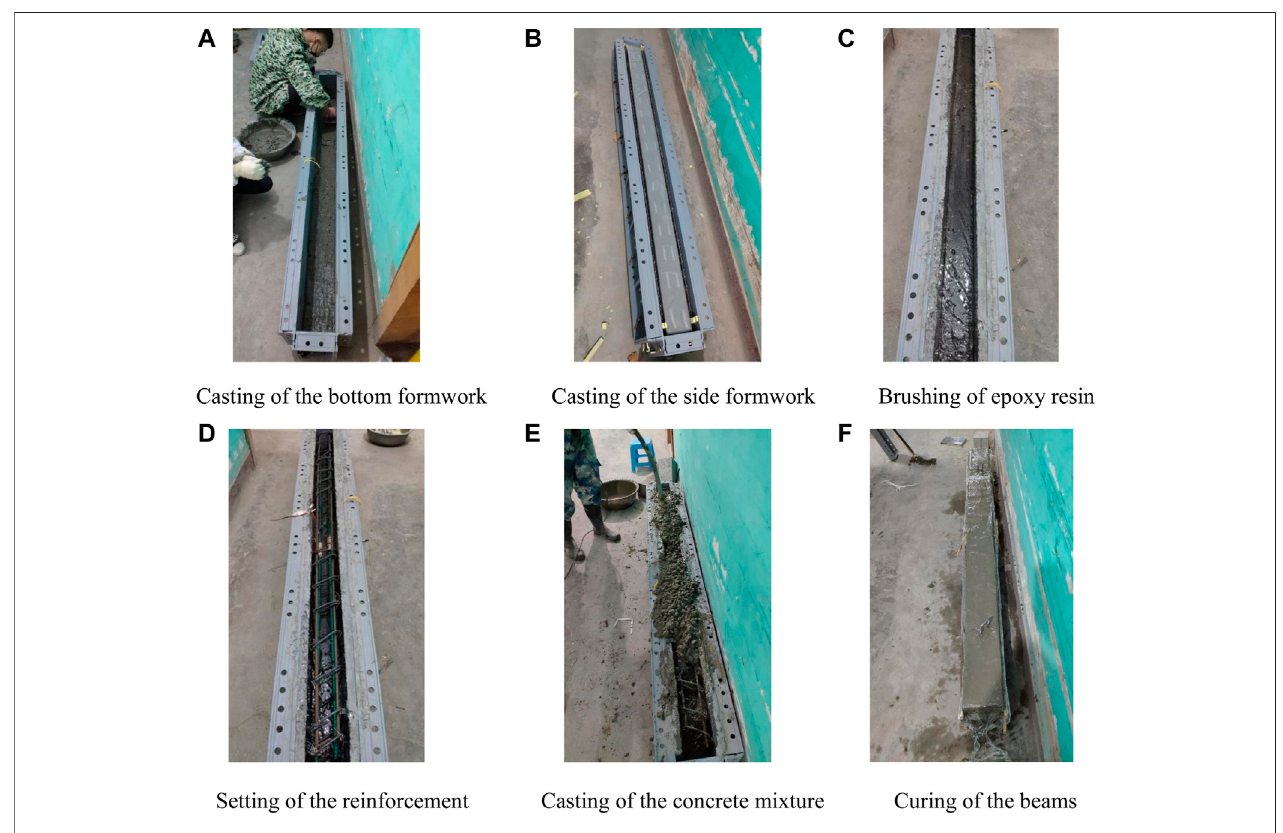
FIGURE 2 | Preparation of the composite beam